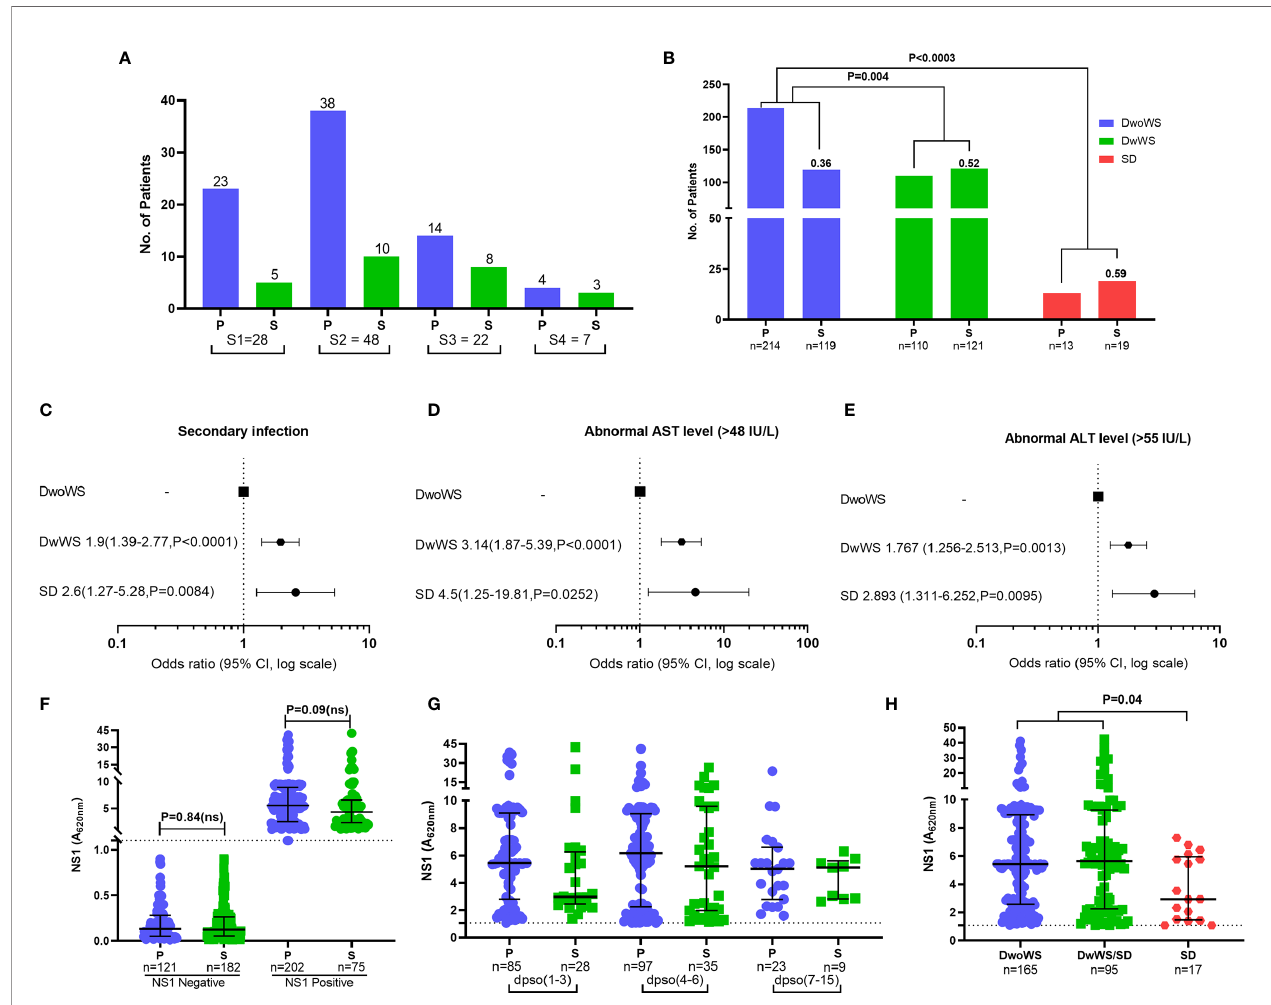
FIGURE 3 | Clinical factors in fl uencing severity in dengue patients. (A) Prevalence of dengue serotypes strati fi ed based on serostatus. (B) Z-score test to compare the proportion of primary/secondary dengue in DwoWS, DwWS, and SD patients. Forest plot showing association of dengue severity with (C) serostatus (D) AST levels, (E) ALT levels and data are odds ratio (95% CI, P-value). (F) Positive and negative non-structural protein 1 (NS1) levels compared between primary and secondary patients. (G) All patients who had detectable dengue speci fi c NS1 levels in serum were compared between primary and secondary based on days post symptom onset (dpso). (H) Levels of dengue NS1 compared between DwoWS, DwWS, and SD patients. P-values were determined using Kruskal – Wallis test, followed by Bonferroni correction for multiple comparisons between groups with median and IQR report. P, primary; S,